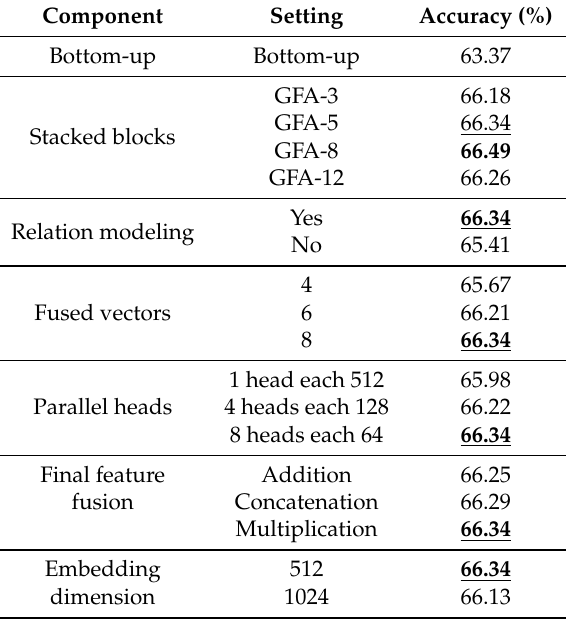
Table 1. Ablation studies of our proposed MGFAN on the Visual Question Answering (VQA)-v2 validation dataset. The default setting is represented by the